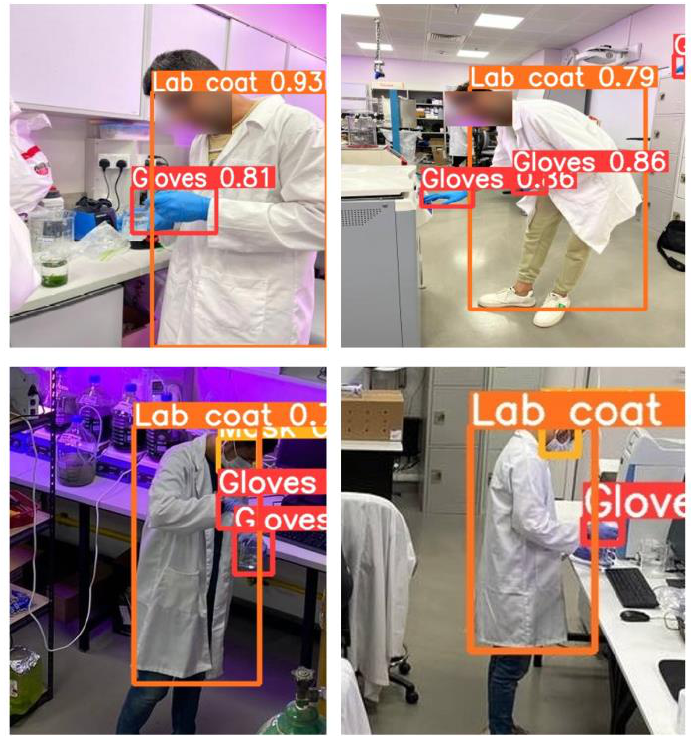
Figure 15. Testing results of the proposed system (YOLOv5m model).